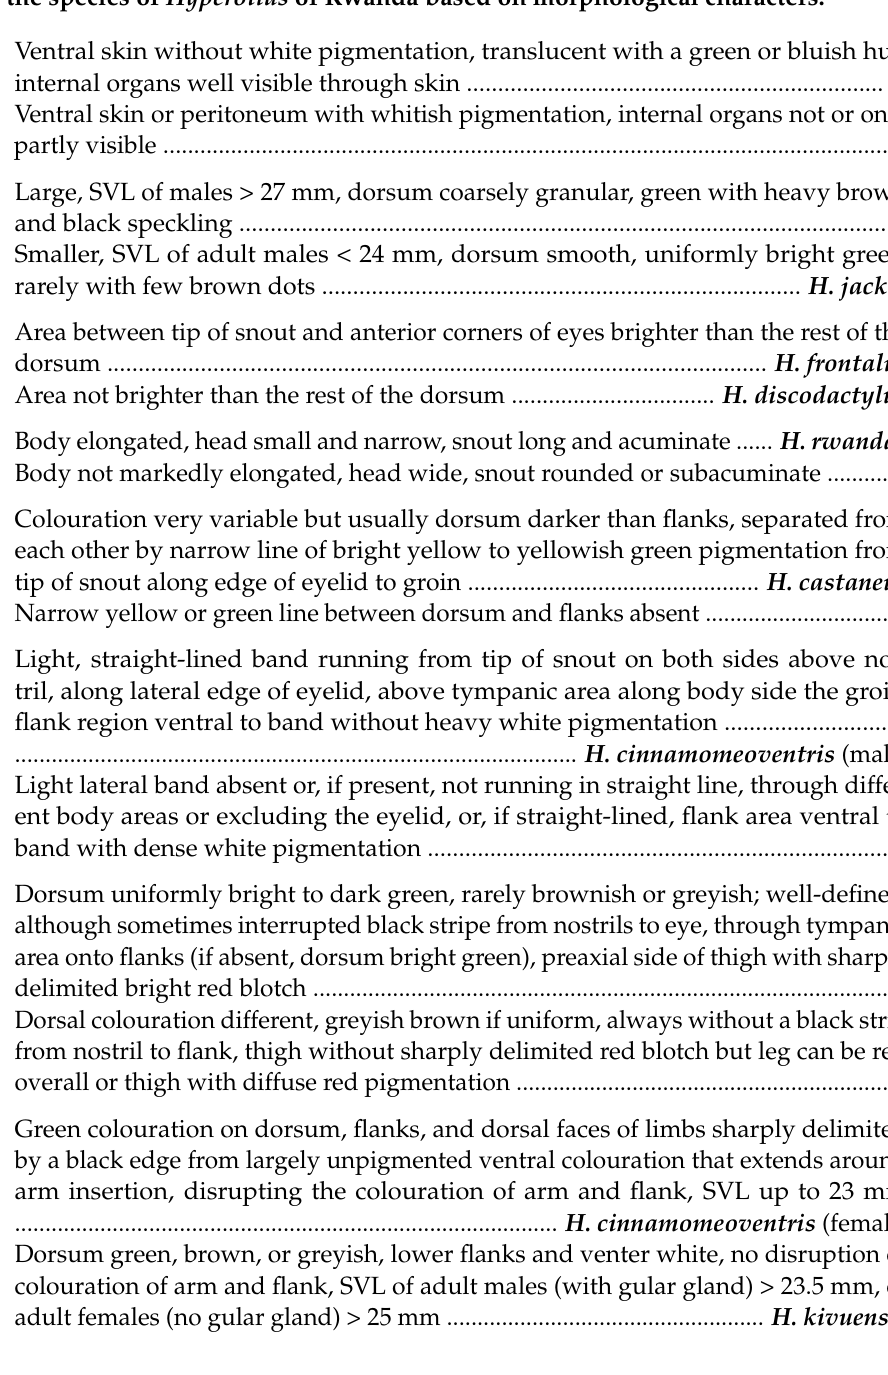
1 (cid:48) Dorsal pattern consisting of irregularly shaped blotches and spots ... A. phantasma 2 Two pairs of sharply delimited longitudinal dark brown dorsal bands, central one extending from level of anterior corners of eyes to end of body, running over bases of upper eyelids, light brown area between the bands without dark spots or speckles ............................................................................................... A. quadrivittatus 2 (cid:48) Usually a single pair of narrow longitudinal dark paravertebral stripes (inconspic- uous second pair of lateral stripes rarely present), from level of anterior corners of eyes to end of body, not running over bases of upper eyelids, dorsum and limbs densely covered with small dark spots ....................................................... A. orophilus Key to the species of Hyperolius of Rwanda based on morphological characters: 1 Ventral skin without white pigmentation, translucent with a green or bluish hue, internal organs well visible through skin ................................................................... 2 1 (cid:48) Ventral skin or peritoneum with whitish pigmentation, internal organs not or only partly visible ...................................................................................................................... 4 2 Large, SVL of males > 27 mm, dorsum coarsely granular, green with heavy brown and black speckling ........................................................................................................ 3 2 (cid:48) Smaller, SVL of adult males < 24 mm, dorsum smooth, uniformly bright green, rarely with few brown dots ............................................................................. H. jackie 3 Area between tip of snout and anterior corners of eyes brighter than the rest of the dorsum .......................................................................................................... H. frontalis 3 (cid:48) Area not brighter than the rest of the dorsum ................................. H. discodactylus 4 Body elongated, head small and narrow, snout long and acuminate ...... H. rwandae 4 (cid:48) Body not markedly elongated, head wide, snout rounded or subacuminate .......... 5 5 Colouration very variable but usually dorsum darker than flanks, separated from each other by narrow line of bright yellow to yellowish green pigmentation from tip of snout along edge of eyelid to groin ............................................... H. castaneus 5 (cid:48) Narrow yellow or green line between dorsum and flanks absent .............................. 6 6 Light, straight-lined band running from tip of snout on both sides above nos- tril, along lateral edge of eyelid, above tympanic area along body side the groin, flank region ventral to band without heavy white pigmentation .............................. ............................................................................................ H. cinnamomeoventris (male) 6 (cid:48) Light lateral band absent or, if present, not running in straight line, through differ- ent body areas or excluding the eyelid, or, if straight-lined, flank area ventral to band with dense white pigmentation .......................................................................... 7 7 Dorsum uniformly bright to dark green, rarely brownish or greyish; well-defined, although sometimes interrupted black stripe from nostrils to eye, through tympanic area onto flanks (if absent, dorsum bright green), preaxial side of thigh with sharply delimited bright red blotch .............................................................................................. 8 7 (cid:48) Dorsal colouration different, greyish brown if uniform, always without a black strip from nostril to flank, thigh without sharply delimited red blotch but leg can be red overall or thigh with diffuse red pigmentation ............................................................. 9 8 Green colouration on dorsum, flanks, and dorsal faces of limbs sharply delimited by a black edge from largely unpigmented ventral colouration that extends around arm insertion, disrupting the colouration of arm and flank, SVL up to 23 mm ......................................................................................... H. cinnamomeoventris (female) 8 (cid:48) Dorsum green, brown, or greyish, lower flanks and venter white, no disruption of colouration of arm and flank, SVL of adult males (with gular gland) > 23.5 mm, of adult females (no gular gland) > 25 mm .................................................... H.